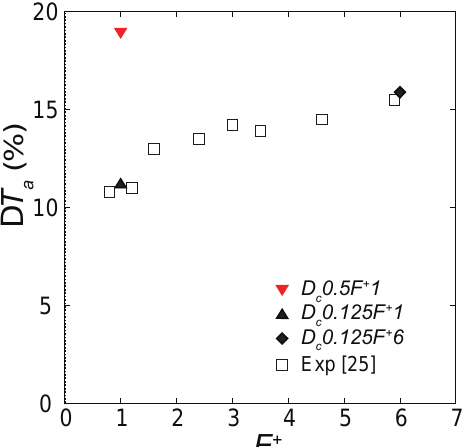
Figure 5. Increase ratios of cycle-averaged axial torque with respect to that of the case without control as a function of F + .